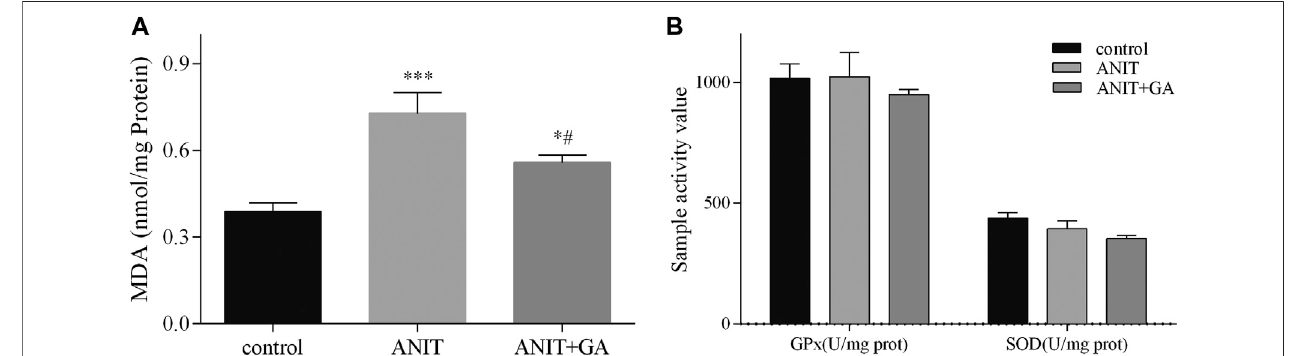
FIGURE 3 | Effects of GA on GPx, SOD (B) , and MDA (A) in liver specimens in ANIT-induced cholestasis mice (n (cid:1) 7 – 8).